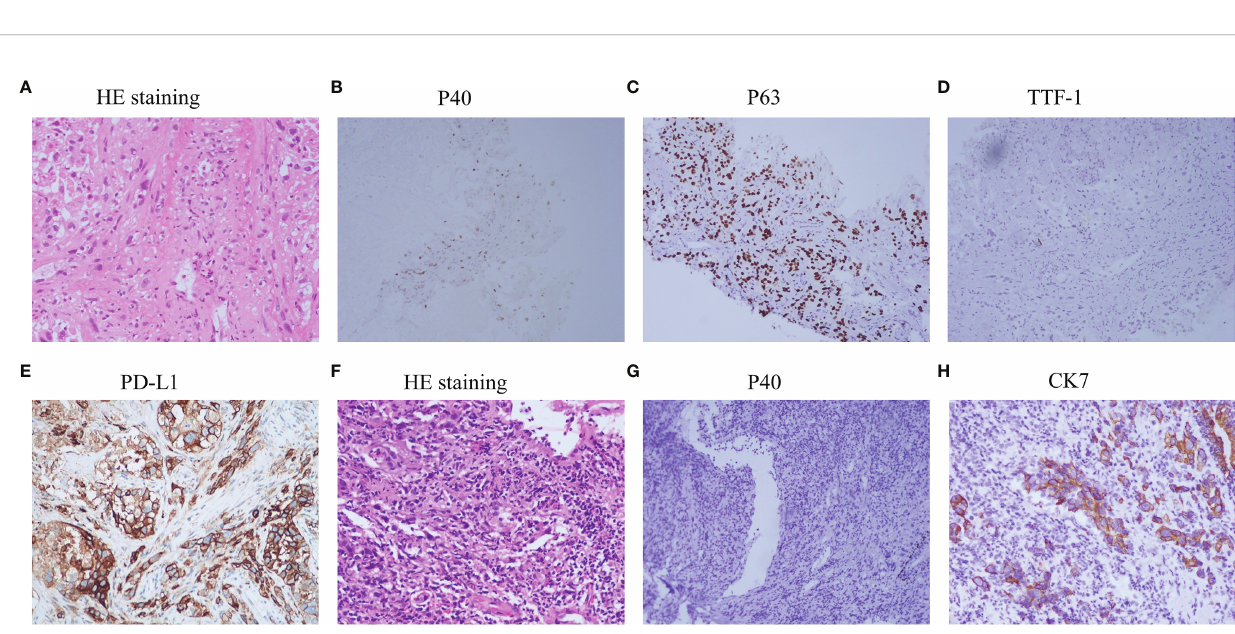
FIGURE 2 | Examinations of pathology and immunohistochemistry. (A – E) , Histology of primary lung lesion (CT guided biopsy) and immunohistochemistry analysis, PD-L1 expression; (F – H) histology of enlarged lung lesion (re-biopsy through electronic bronchoscopy) and immunohistochemistry